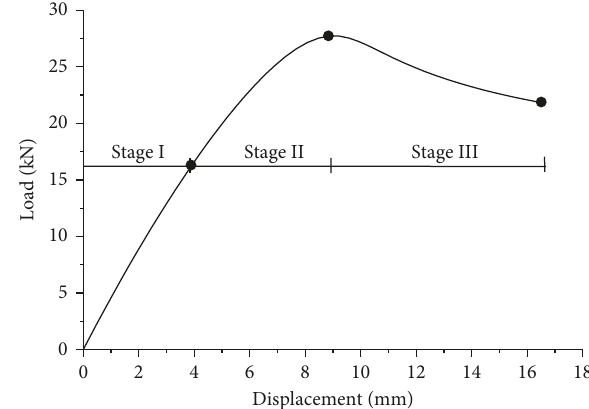
Figure 4: Load-deflection in the midspan